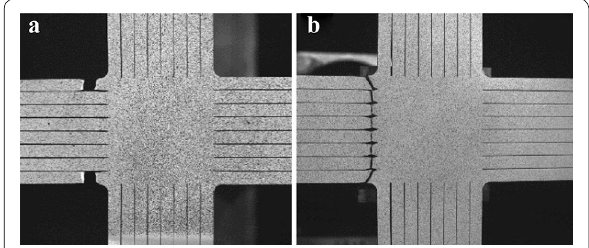
Figure 8 Cruciform pecimens tested at ( a ) 25 °C and ( b ) 230 °C with a force ratio ( F x : F y ) of 2:1